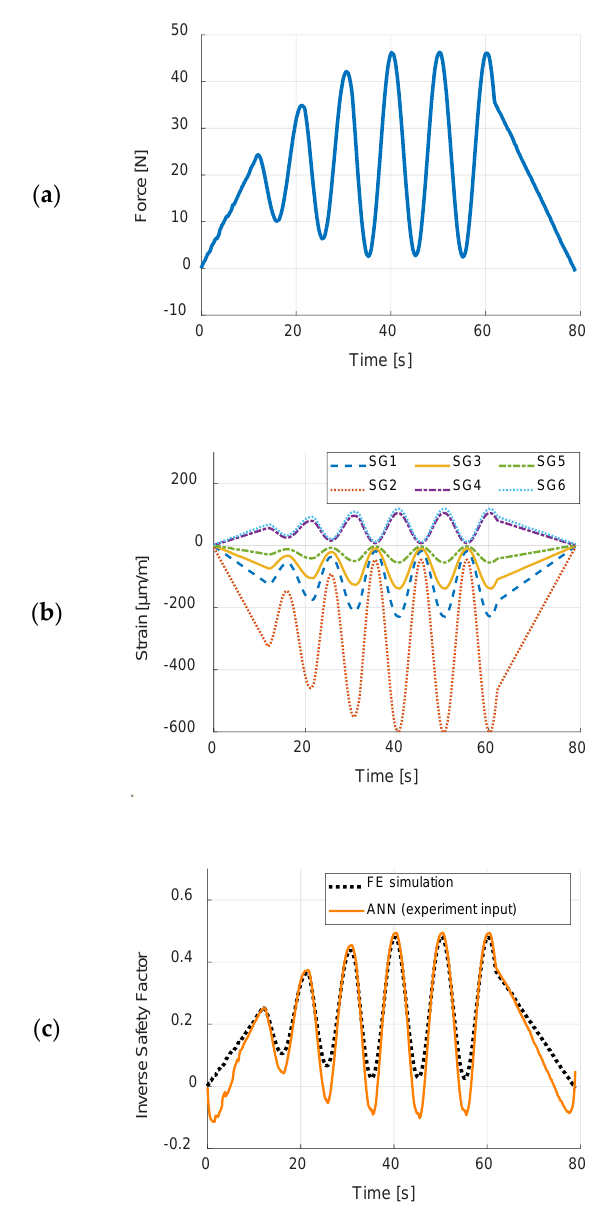
Figure 14. Results of on-line testing of the ANN: ( a ) time course of applied force; ( b ) time courses of acquired strain values from strain gages; and ( c ) comparison between time courses of ISF estimated from ANN and exact values from finite element (FE) simulations.